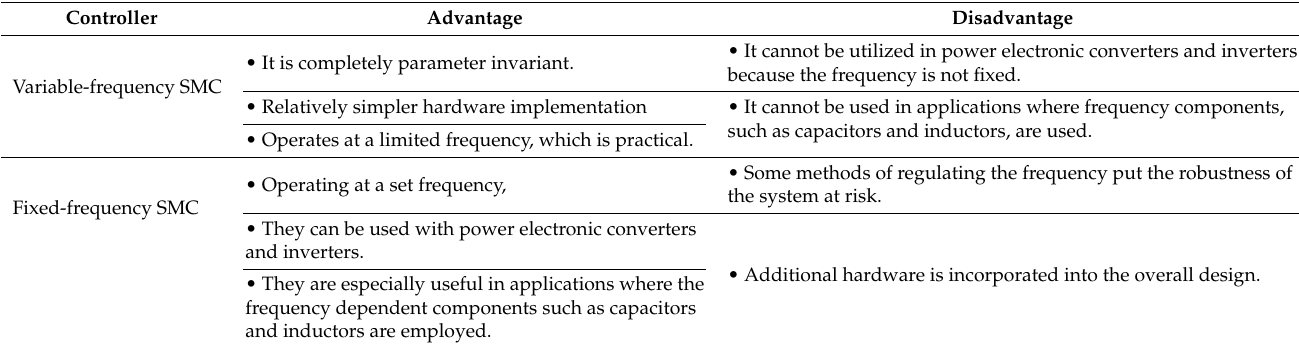
Table 1. Advantages and disadvantages of variable- and fixed-frequency SMC.